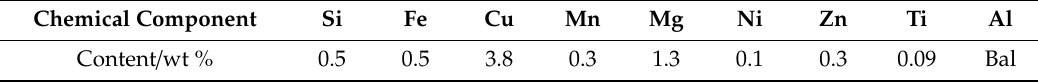
Table 1. Chemical composition of aluminum alloy 2024.